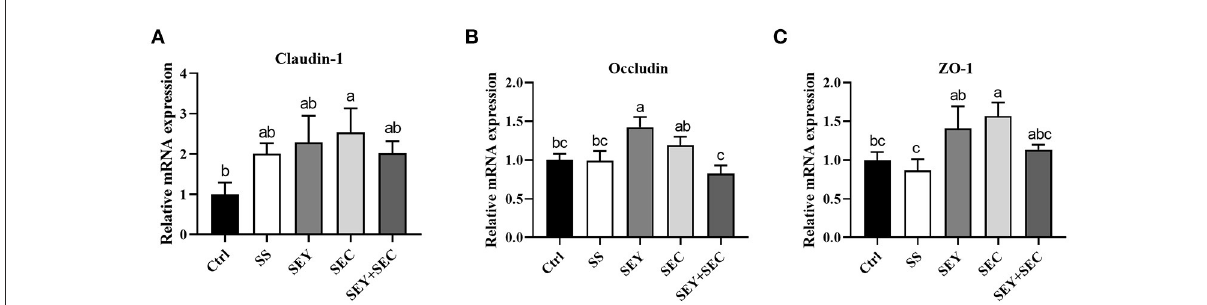
FIGURE3 Effects of different Se sources on tight junction protein mRNA expression in the jejunum. (A–C) The mRNA expression of claudin-1 (A) , occludin (B) , and ZO-1 (C) in the jejunum. Values are means ± SEM, n = 6. a,b,c Means without a common letter differ, P < 0.05. Ctrl, control group; SS, sodium selenite; SEY, Se-enriched yeast, SEC, Se-enriched Cardamine violifolia ; SEY + SEC, Se-enriched yeast + Se-enriched Cardamine violifolia .